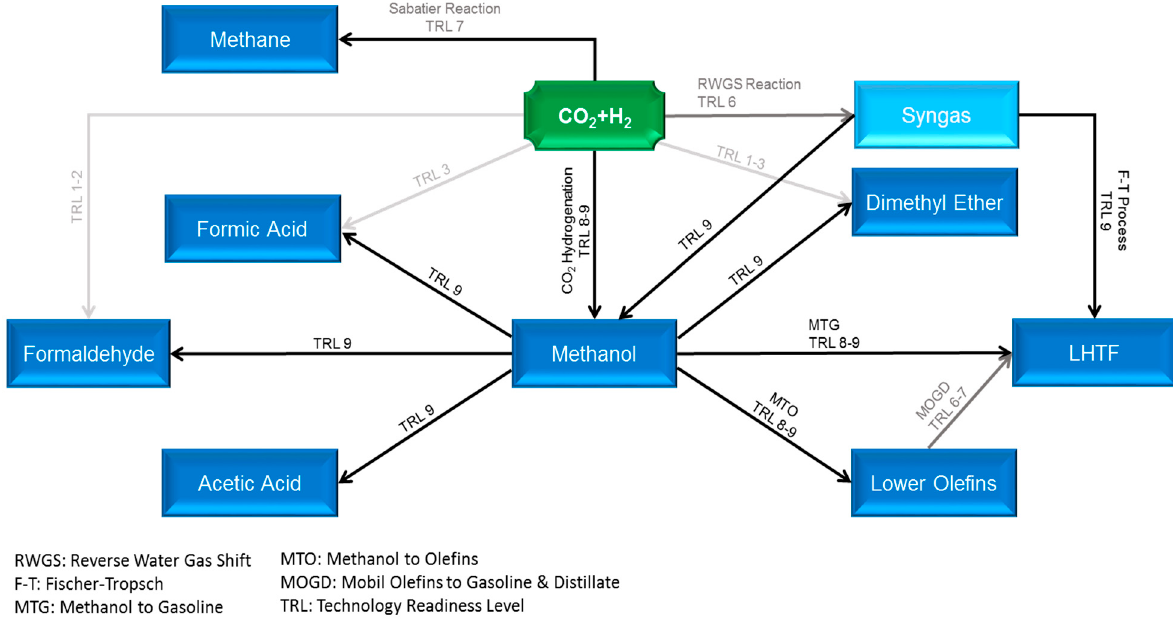
Figure 1. Carbon utilization pathways via thermocatalytic conversion with Technology Readiness Levels (TRLs) (blurred to sharp fonts denote low to high TRLs).